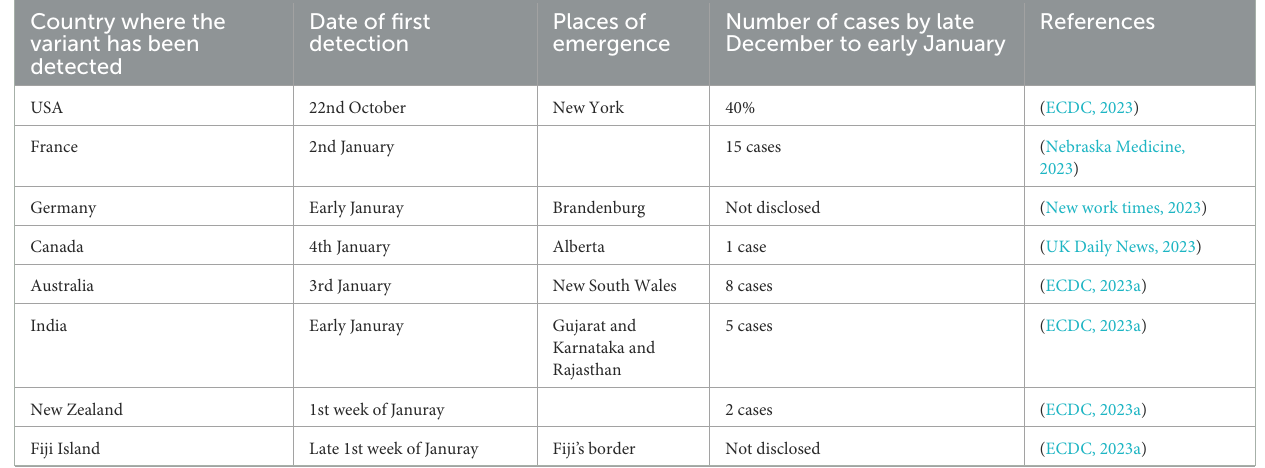
TABLE 1 The outbreaks of novel XBB1.5 variant since October 2022. Country where the variant has